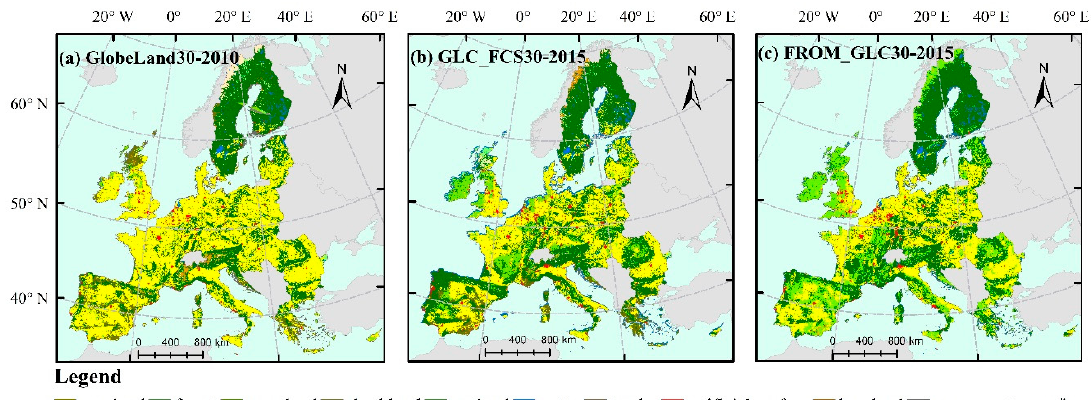
Figure 3. Spatial distribution of land-cover types in the three global land-cover products covering the European Union: ( a ) GlobeLand30-2010, ( b ) GLC_FCS30-2015, and ( c ) FROM_GLC 2015.